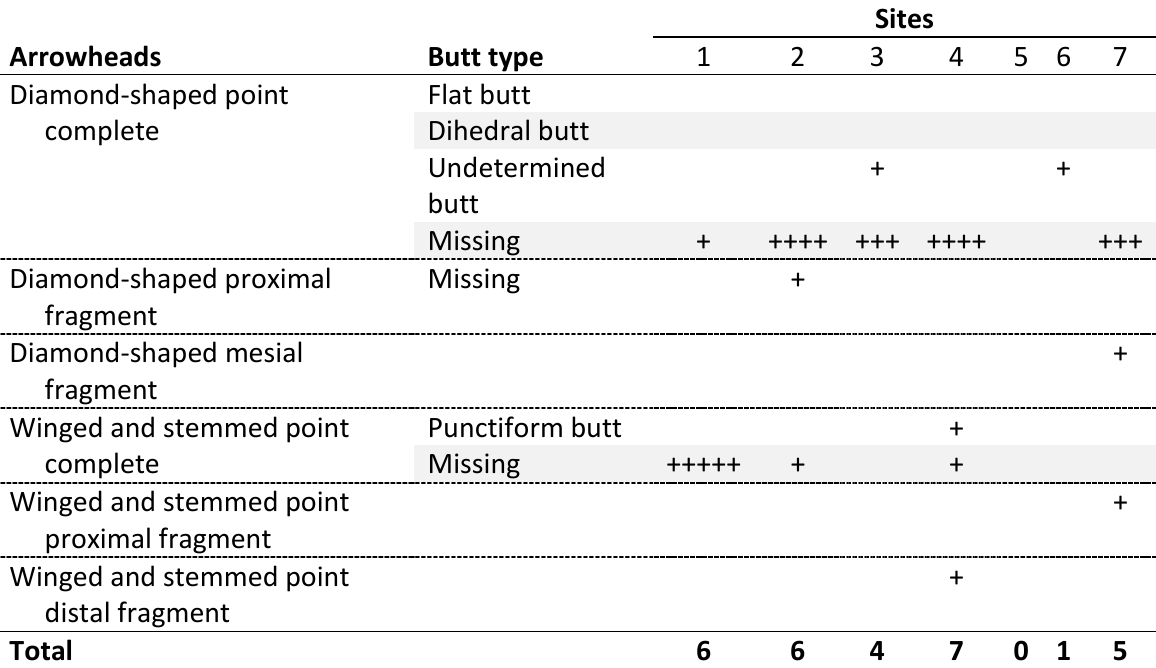
Table 3. Technological approach to arrowheads. Types of butt. Sites. 1. Cova de la Guineu; 2. Cova de la Font del Molinot; 3. Esquerda de les Roques del Pany; 4. Cova Foradada; 5. Avenc de Sant Antoni: 6. Cova del Pantà de Foix; 7. Cova de